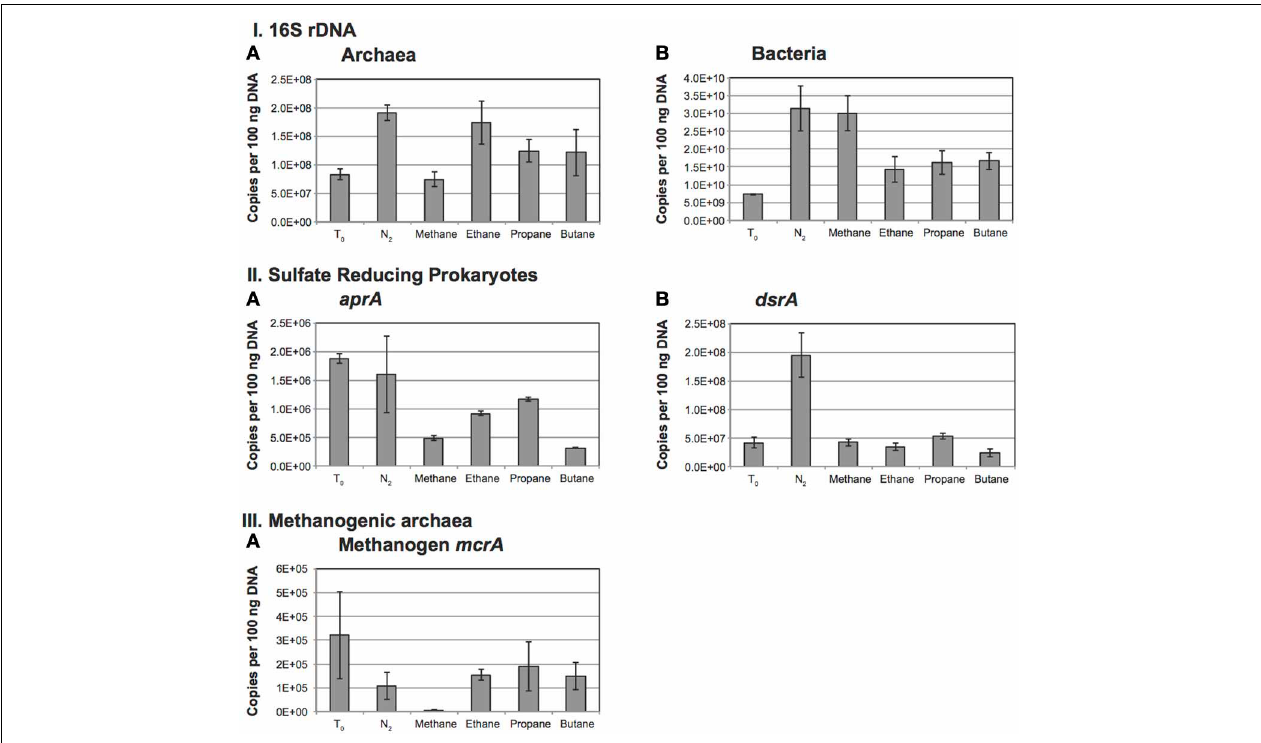
FIGURE 5 | Abundance of microbes determined using quantitative PCR. Panel (I) represents the 16S rRNA abundances for A: Bacteria and B: Archaea. Panel (II) represents the abundance of